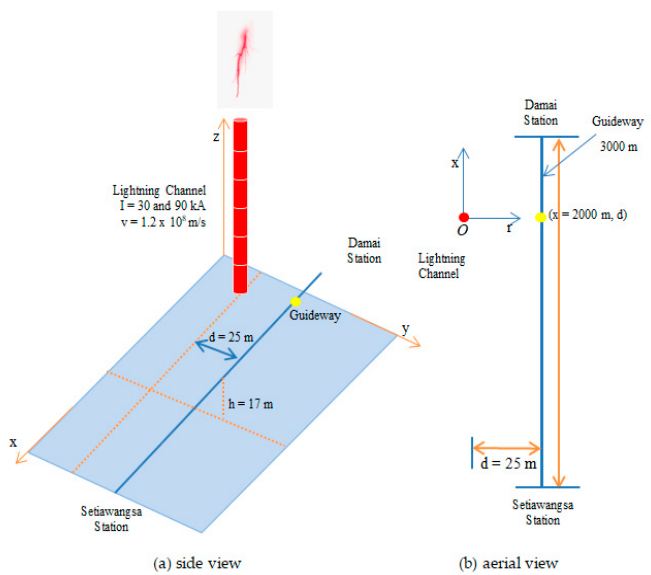
Figure 6. Illustration of the simulation configuration. The induced overvoltage profiles for the CE, CEA, and GRP brackets are shown in Figure 7. There were only four brackets needed in the rail model portraying the 3 km distance from Setiawangsa Station to Damai Station, where one bracket is installed for every 1-km distance.